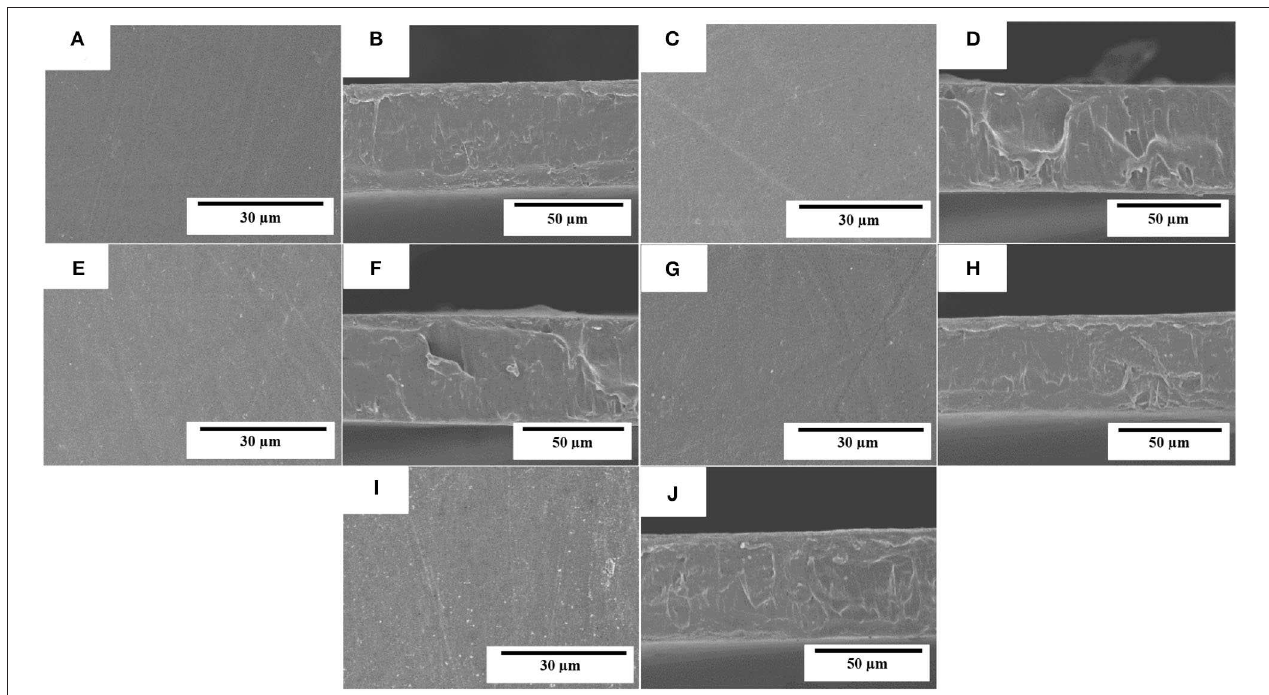
FIGURE 4 | Scanning electron microscopy (SEM) micrographs of the electrospun monolayers of poly(3-hydroxybutyrate- co -3-hydroxyvalerate) (PHBV) containing eugenol: (A,B) neat PHBV; (C,D) 2.5 wt.%, eugenol; (E,F) 5 wt.%; (G,H) 10 wt.%; (I,J) 15 wt.% eugenol. Scale markers of 30 µ m for top views and of 50 µ m for